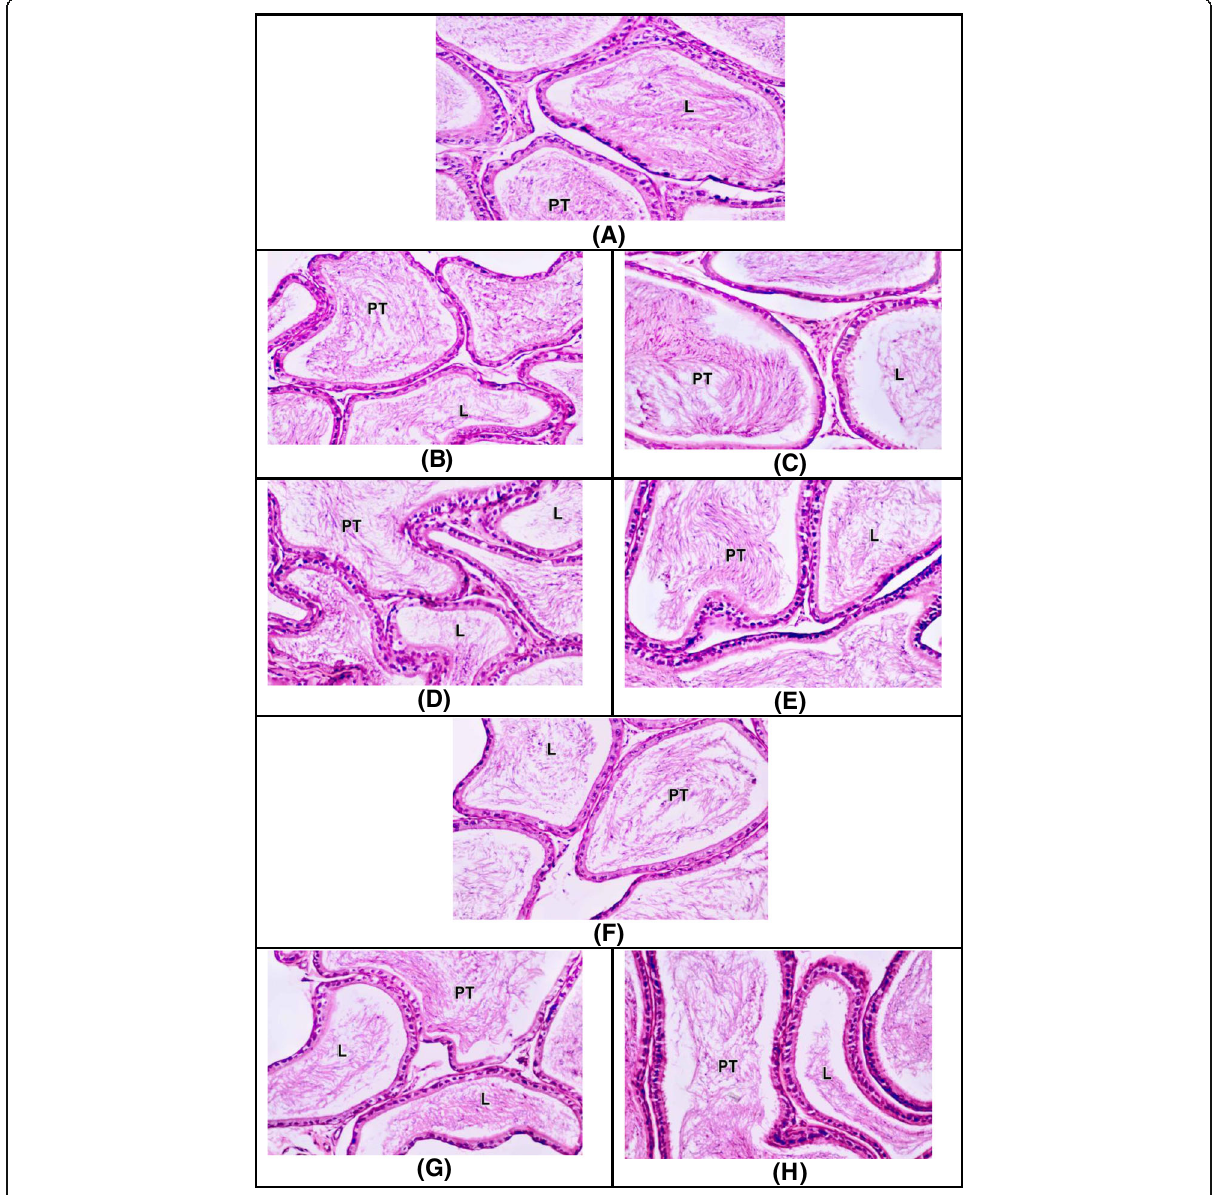
Fig. 2 a Photomicrograph of control epididymis showing normal histological structure of the epididymal tubules (PT) with lining columnar epithelium (arrow) and lumen impacted by sperms (L) (H&E × 200). b – e Photomicrographs of epididymis of the first, second, third, and fourth treated groups showing columnar lining epithelium of the epididymal tubules (PT) with reduction in the number of sperms in lumen (L) (H&E × 200). f – h Photomicrographs of epididymis of the fifth, sixth, and seventh treated groups showing columnar lining epithelium of the epididymal tubules (PT) with large reduction in the number of sperms in lumen (L) (H&E ×